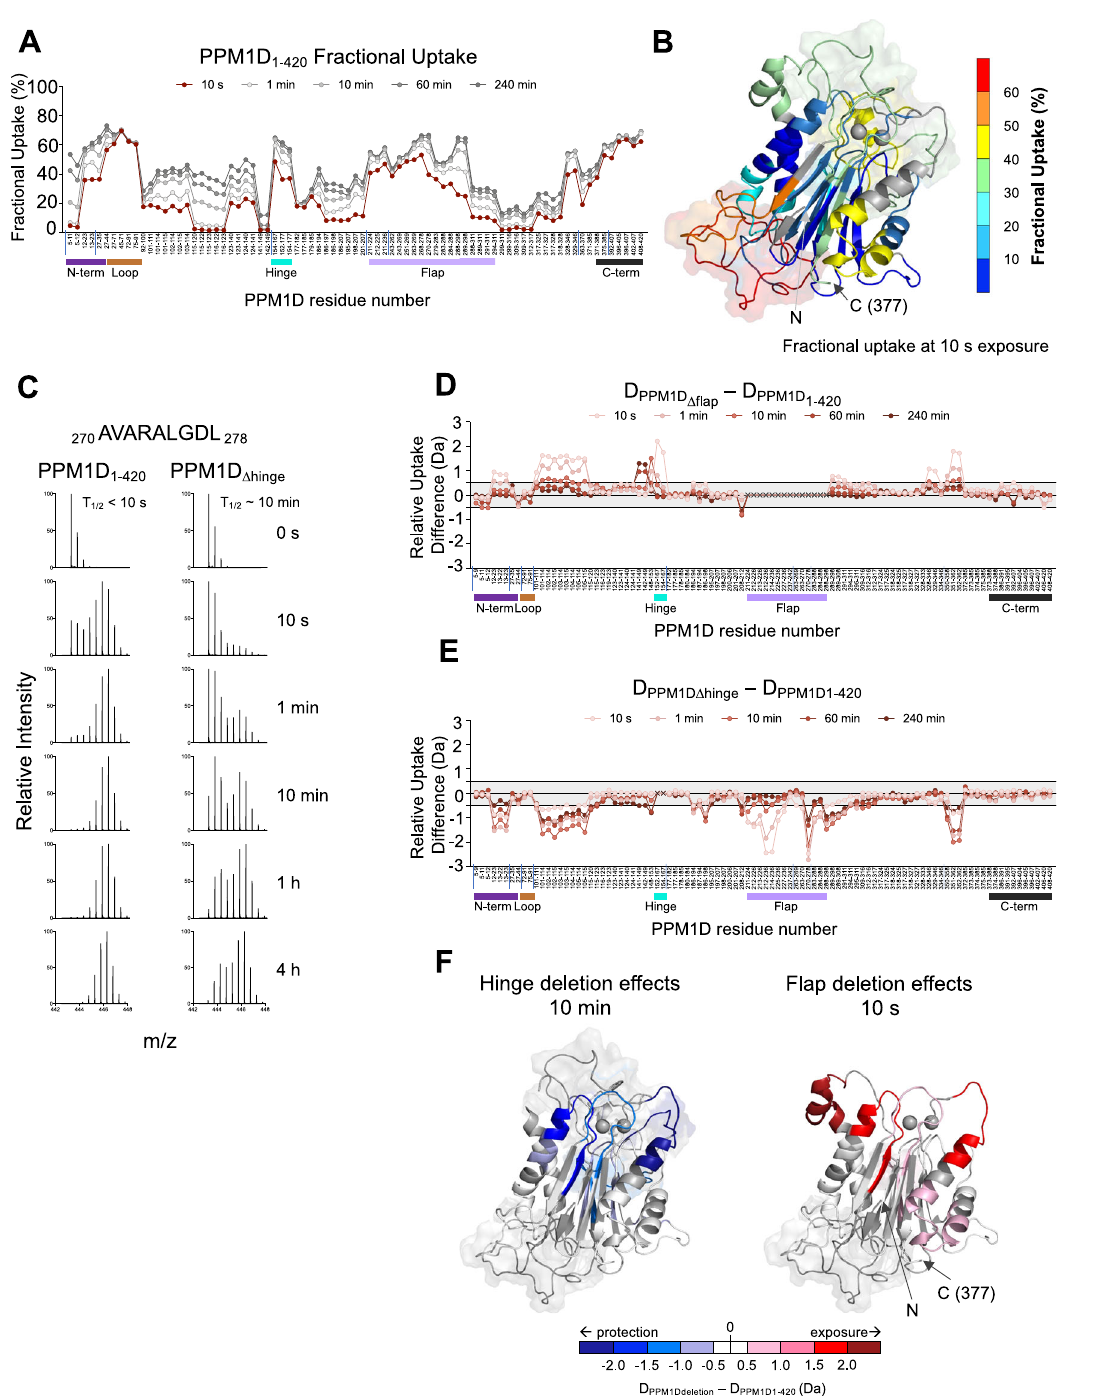
Fig. 4 PPM1D exists in multiple conformational states re fl ected by movement of the fl ap domain. A HDX-MS measurements of deuterium uptake for PPM1D 1 – 420 over time. The peptides analyzed run along the X -axis from the N-terminus (left) to C-terminus (right) and vertical tick marks between peptides are shown to indicate regions of missing coverage. Deuterium incorporation is represented as percent fractional uptake on the Y -axis, calculated as described in the “ Materials and Methods ” section. The 10 s exposure time point is shown in red to highlight the uptake values mapped in panel B . Reference plots are reported in Suppl. Data 1, the raw values of the plots are reported in Suppl. Data 2 B Fractional uptake at 10 s exposure for PPM1D 1 – 420 mapped onto the homology model. C Spectral analysis showing the change in EX1 kinetics for peptide 270 AVARALGDL 278 located in the fl ap region in PPM1D 1 – 420 and PPM1D Δ hinge . D Relative differences in deuterium uptake between PPM1D Δ fl ap compared to PPM1D 1 – 420 . E Relative differences in deuterium uptake between PPM1D Δ hinge compared to PPM1D 1 – 420 . F Differences shown in panels ( D , E ) between PPM1D Δ hinge (left) or PPM1D Δ fl ap (right) and PPM1D 1 – 420 mapped onto homology model. Negative differences are represented in blue indicating protection from exchange, while positive differences are shown in red, indicating exposure to exchange as a result of the deletion. Darker colors indicate a stronger relative difference. For panels ( A , D , E ) the bars below the X -axis represent the N-terminus (purple), loop (brown), hinge (cyan), fl ap (light purple), and C-terminus (black) of the protein. Source data are provided as a Source Data fi le.